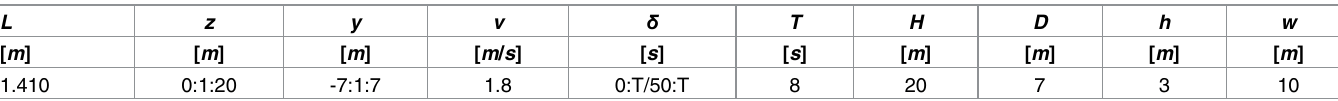
Table 1. Parameters used for the baseline case. The midpoint of the flightpath is at y = 0 m . Lists are definedas start:increment:final value. L